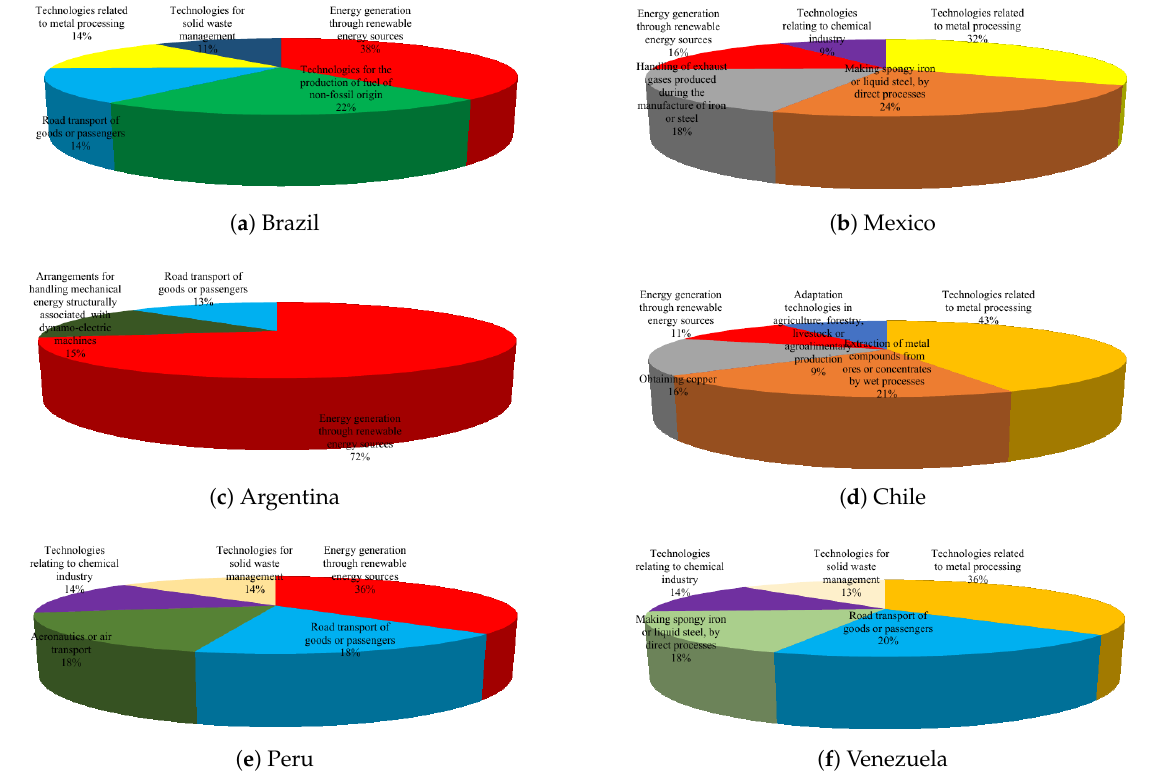
Figure 12. Top five published patents by country in mitigating CO 2 emission